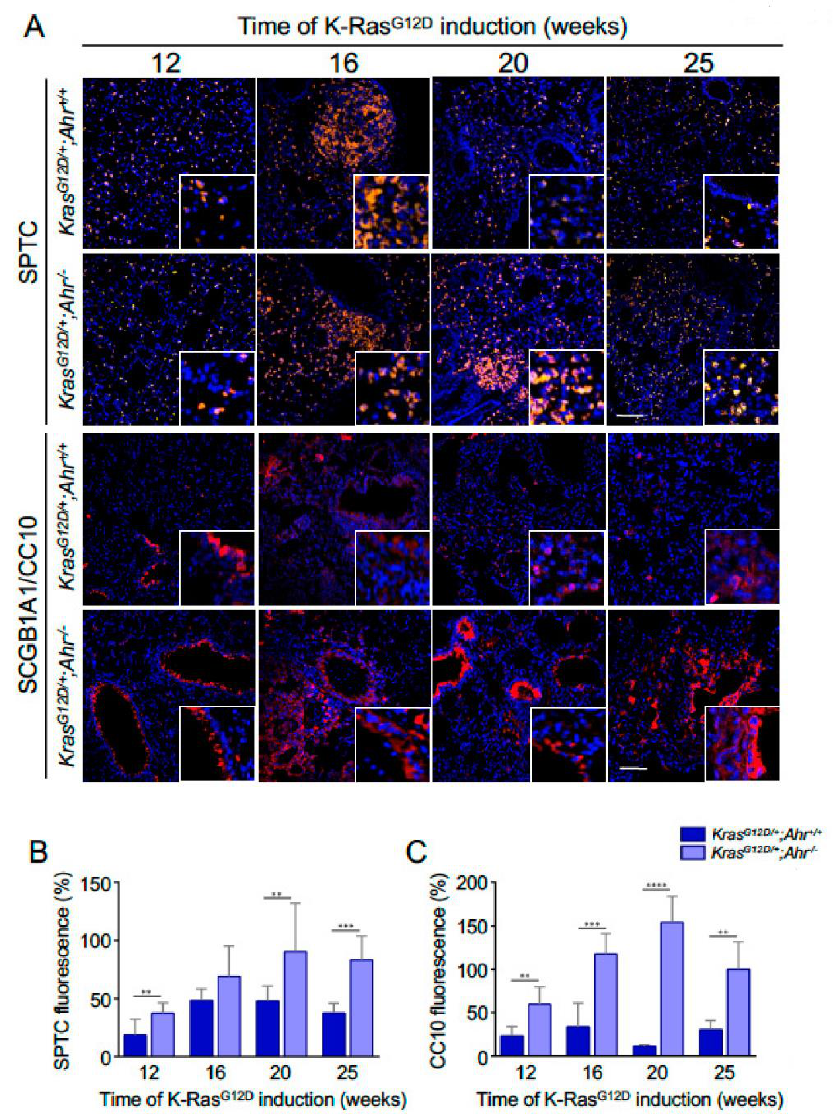
Figure 2. Lung progenitor cells expressing SFTPC and SCGB1A1/CC10 markers are upregulated in K-Ras G12D/+ ; Ahr –/– mice . ( A ) Sections from K-Ras G12D/+ ; Ahr +/+ and K-Ras G12D/+ ; Ahr − / − lungs were analyzed by immunofluorescence to identify surfactant-producing (SFTPC + ) or Clara (SCGB1A1/CC10 + ) progenitor cells. ( B , C ) The expansion of SFTPC-positive ( B ) or SCGB1A1/CC10-positive ( C ) cells with time of K-Ras G12D induction was quantified from 12 to 25 weeks in each mouse genotype. The conjugated secondary antibodies were Alexa-550 and Alexa-633 for SFTPC and SCGB1A1, respectively. Sections were analyzed using an Olympus FV1000 confocal microscope and the FV10 software (Olympus, Shinjuku, Japan). DAPI staining was used to label cell nuclei. Bar corresponds to 100 µ m. Data are shown as mean + SD (** p < 0.01; *** p < 0.001; **** p <